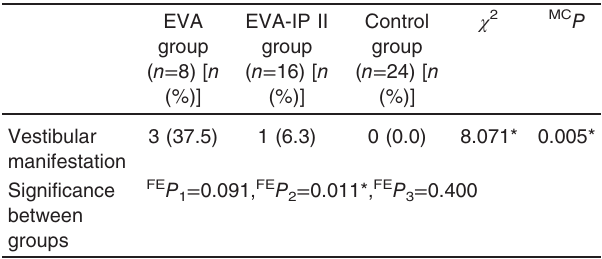
Table 1 Comparison among the three studied groups according to associated vestibular